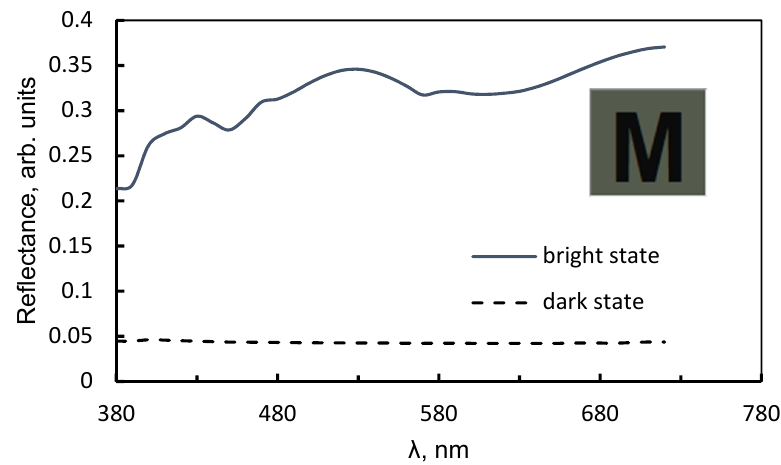
Figure 9. (Color online) Reflectance spectrum of ORW e-paper for bright- and dark states. The insert: computer-generated image with the reflective coefficients of 0.3285 and 0.0426 for bright and dark states, respectively.